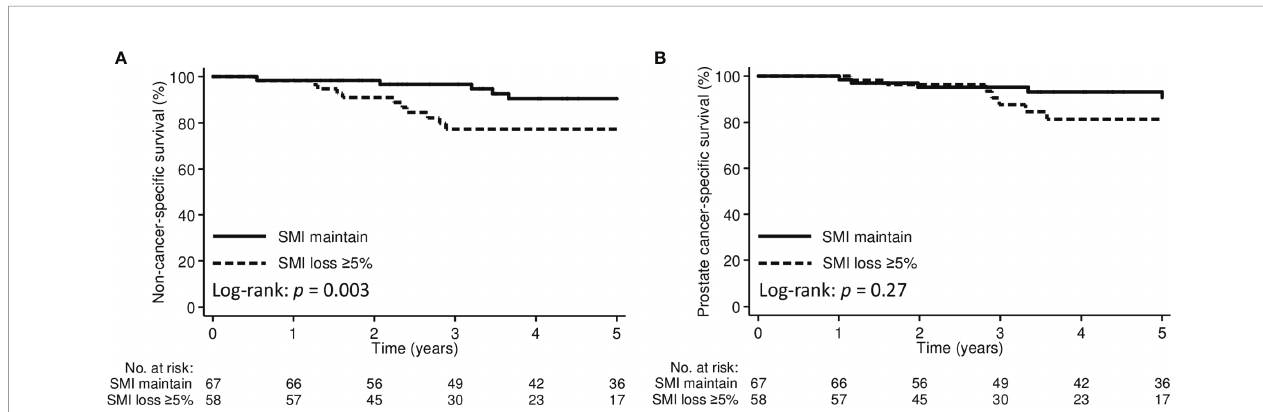
FIGURE 3 | Kaplan-Meier curve demonstrating (A) non-cancer-speci fi c survival and (B) prostate cancer-speci fi c survival according to SMI change groups. SMI, skeletal muscle index.